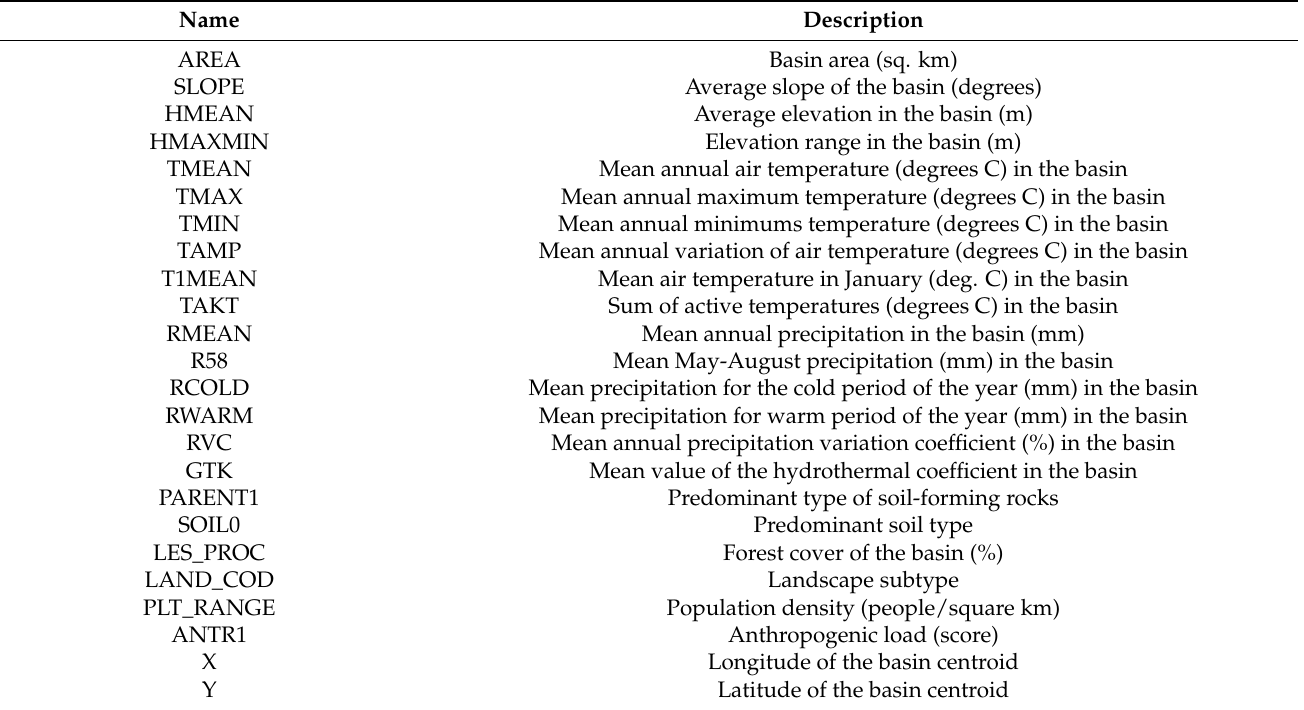
Table 1. Natural–anthropogenic factors of rill erosion selected for analysis